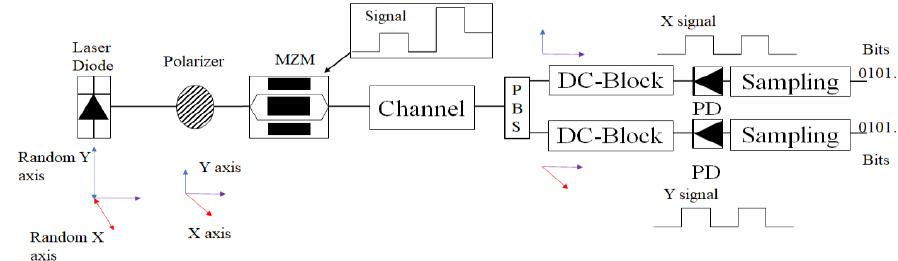
Figure 1. Overall schematic of the proposed scheme.